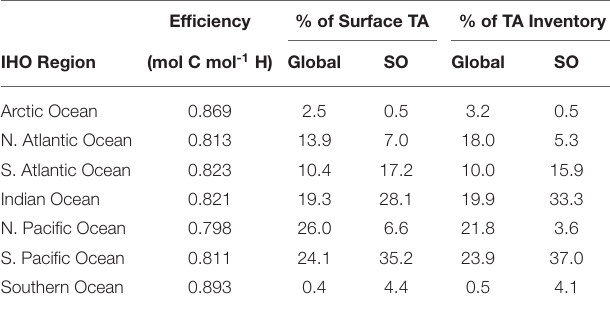
TABLE 2 | Major oceans following International Hydrographic Organization region definitions, their mean carbon-uptake efficiency and the percentage of total surface total alkalinity anomaly and total alkalinity inventory anomaly within the region for the Global and Southern Ocean (SO) ocean alkalinity enhancement